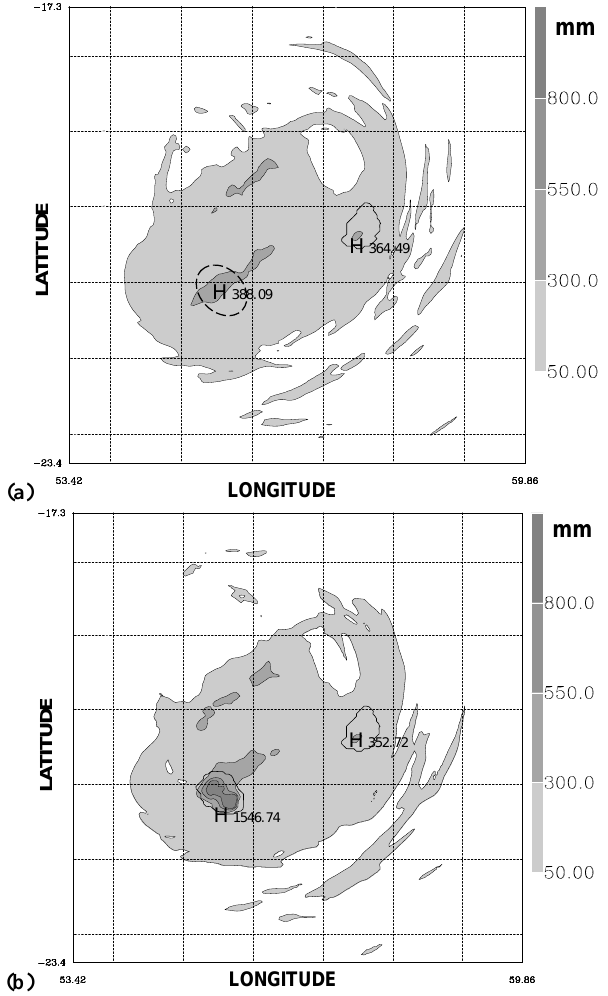
Fig. 7. (a) 24h accumulated rainfall from 0 to 24h (shaded, mm) for “ Ocean ”. The dashed line contour indicates the location of R´eunion island in “ Ocean ”; (b) as in (a) , except for “ Island